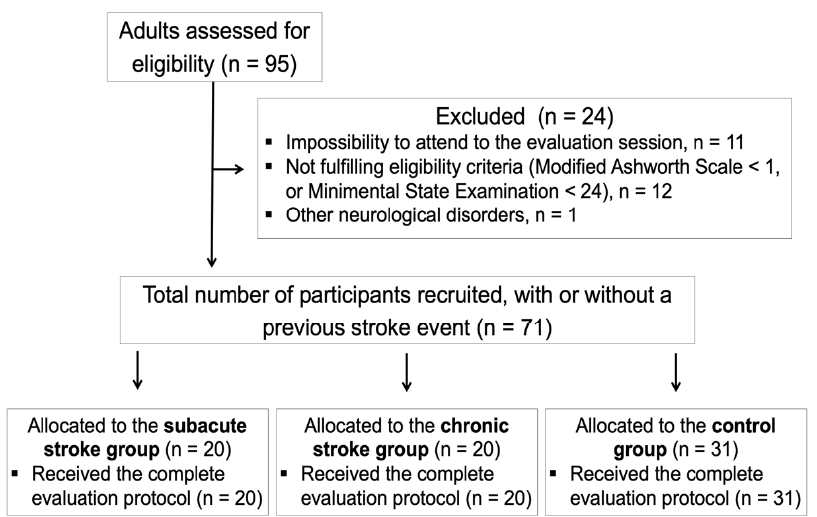
Figure 2. Flowchart diagram of the study participants.